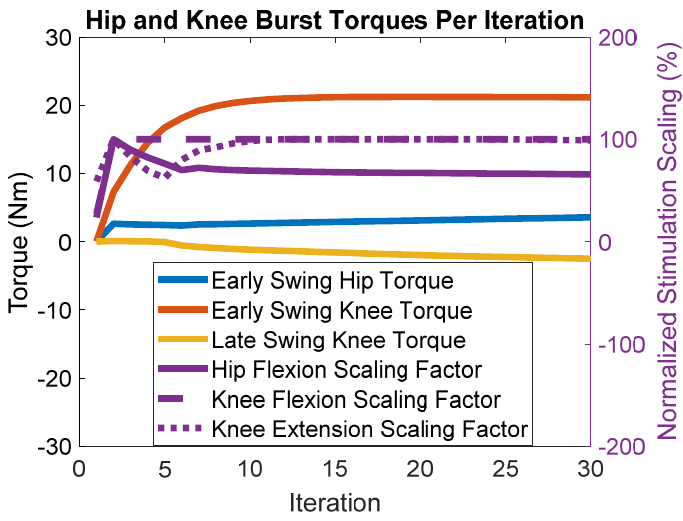
Figure 4. Muscle and motor recruitment over each iteration. For the left-hand axis, positive values are flexion, negative is extension. Early swing torques are executed at the onset of swing. Late swing knee torque extends the knee to prepare for weight acceptance. Purple lines represent neural stimulation scaling factors and are normalized using the scale on the right-hand axis. A scaling factor of 100% means that the muscles reached the maximum, i.e., the scaling factor produces a maximal pattern with peak pulse.